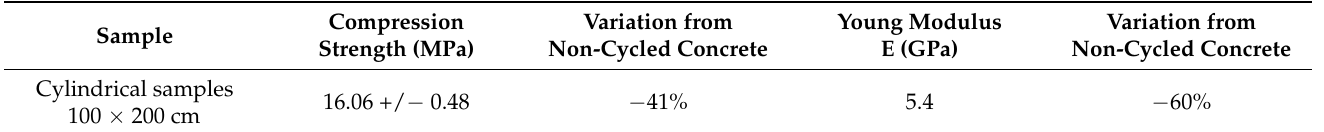
Table 16. Compression strength test results and elastic modulus (Young modulus) of insulating refractory concrete cylindrical samples after 100 thermal cycles.